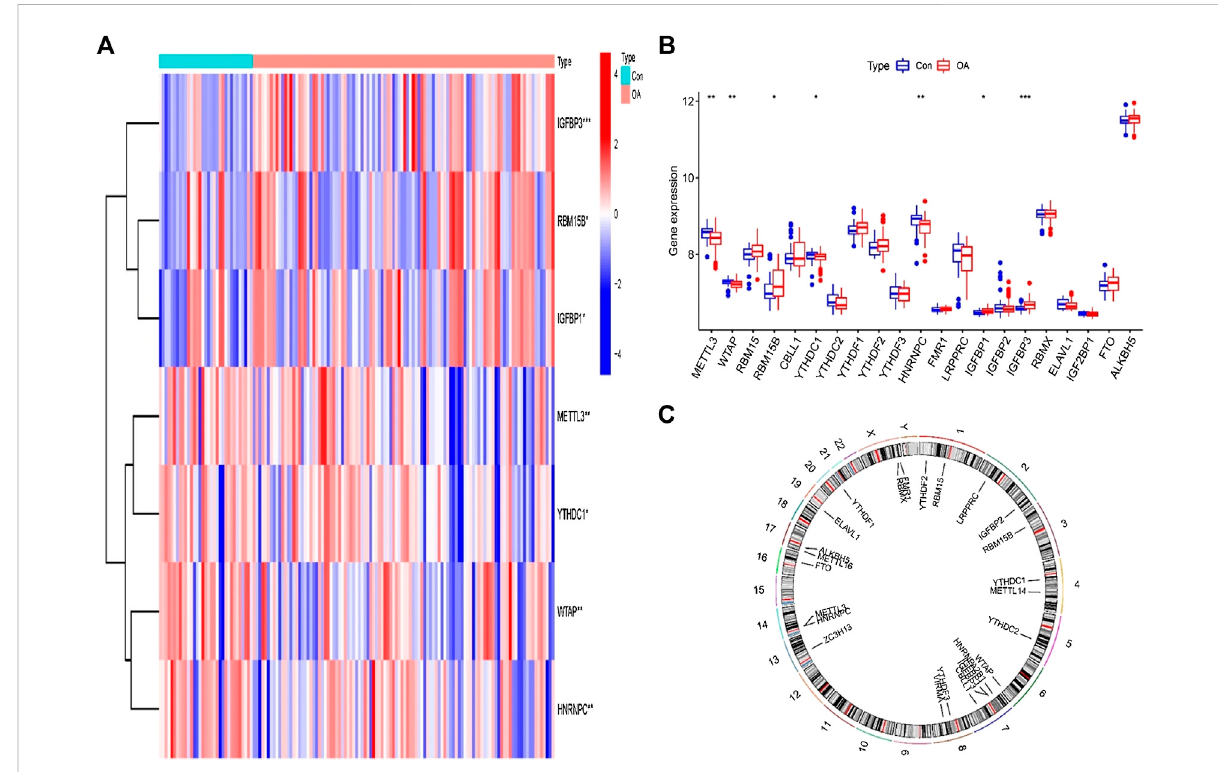
FIGURE 2 m 6 Amodulatorsinosteoarthritis(OA). (A) Heatmapsoftheexpressionofsevenimportantm 6 Aregulators